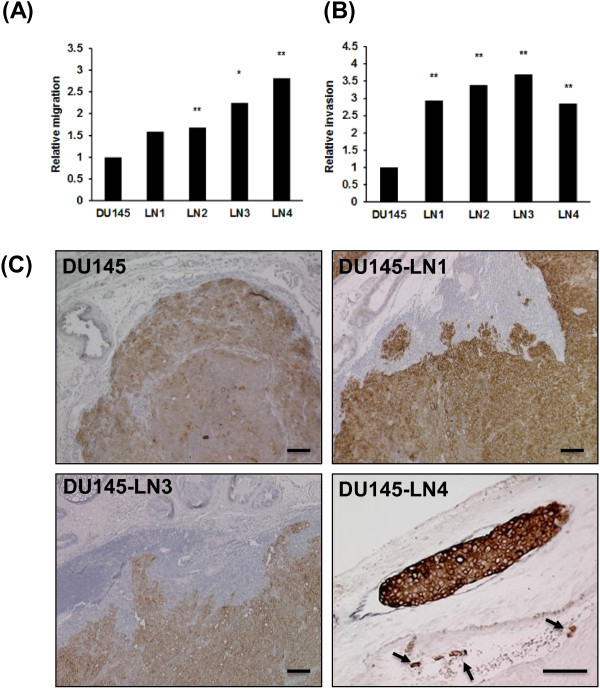
DU145-LN sublines exhibit increased migration and invasion with metastatic ability, relative to DU145 cells. DU145-LN metastatic sublines show increased (A) cell migration in the transwell migration assay and (B) increased invasion in the Matrigel invasion assay. For both assays: Mean of triplicate assays ± S.D. Student t-test, *p < 0.05, **p < 0.01, (C) IHC of orthotopic prostate tumors with K18 (brown) and counterstained with hematoxylin (blue). Margins were smooth and well-defined in the DU145 tumors (top left panel), while invasive margins were observed in DU145-LN1 (top right panel) and DU145-LN3 (lower left panel) tumors. Right lower panel shows magnified image of DU145-LN4 tumor seen in Figure 2A. Double staining of K18 (brown) and podoplanin (black) shows tumor foci present in an enlarged lymphatic vessel and in a tumor-associated blood vessel (arrows) (lower right panel). Scale bars = 100 μm.